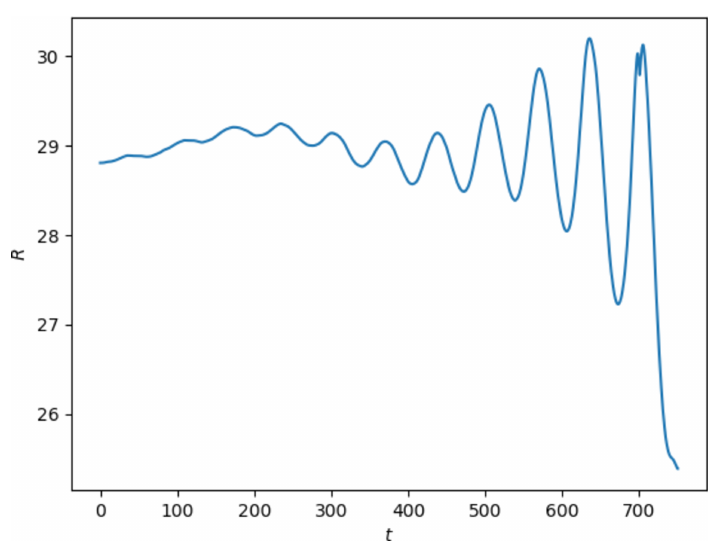
Figure 25 . The evolution of the position of the core of the string along y = z = 0 during 3D dynamics. We have stopped the simulation at t = 750 , at which point the unstable vorton begins to break apart and collapse. This plot is predominantly described by a superposition of the zero mode and an exponentially growing square mode.